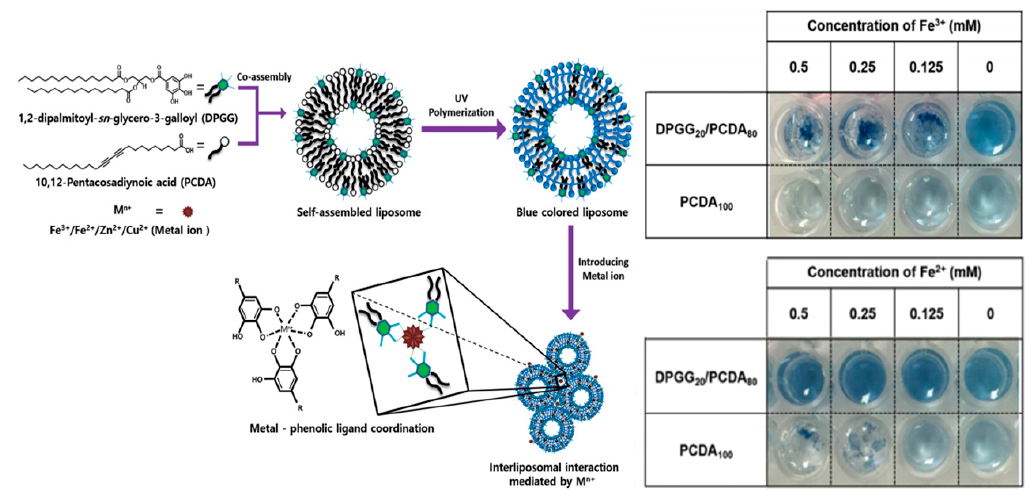
Figure 4. Schematic illustration of metal ion-mediated coagulation behavior of liposomes consisting of phenolic lipids. The coagulation was noticeable by increasing concentrations of Fe 3+ ions [44].